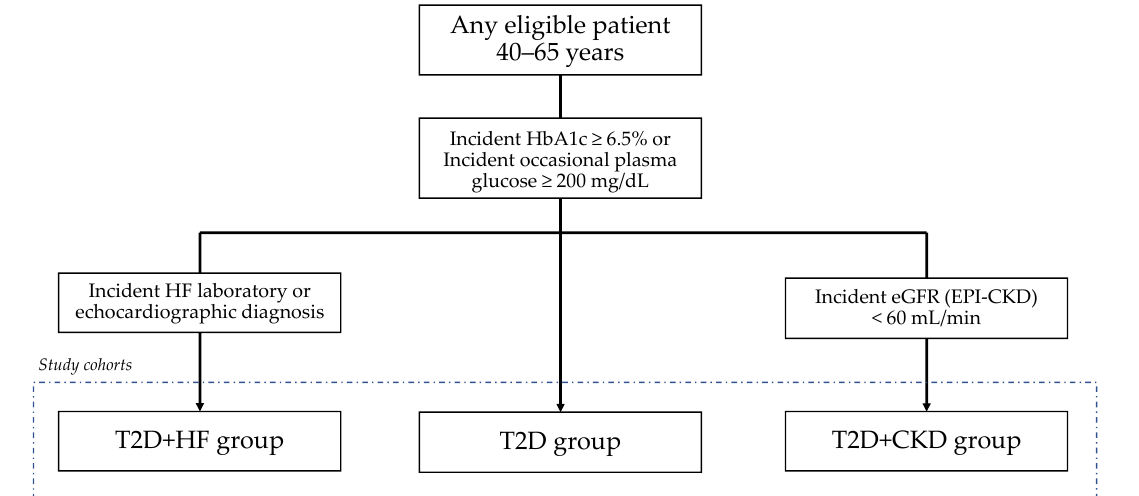
Figure 1. Flowchart of the study cohort design allowing for the simultaneous inclusion of all eligible patients aged 40–65 years. HF, heart failure; CKD-EPI, chronic kidney disease epidemiology collaboration; T2D, diabetes mellitus type 2; HbA1c, hemoglobin A1c; eGFR, estimated glomerular filtration rate.